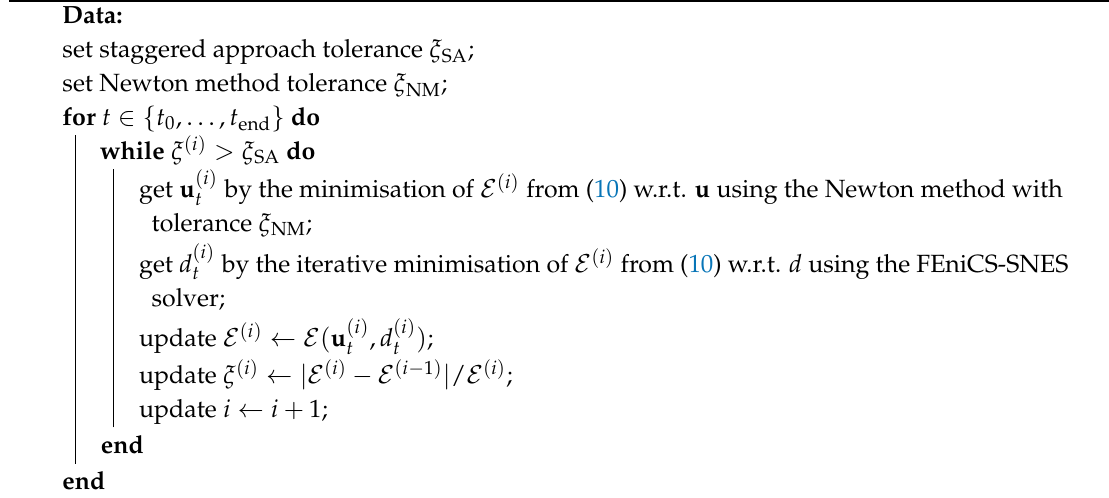
Algorithm 1: Anisotropic staggered approach.